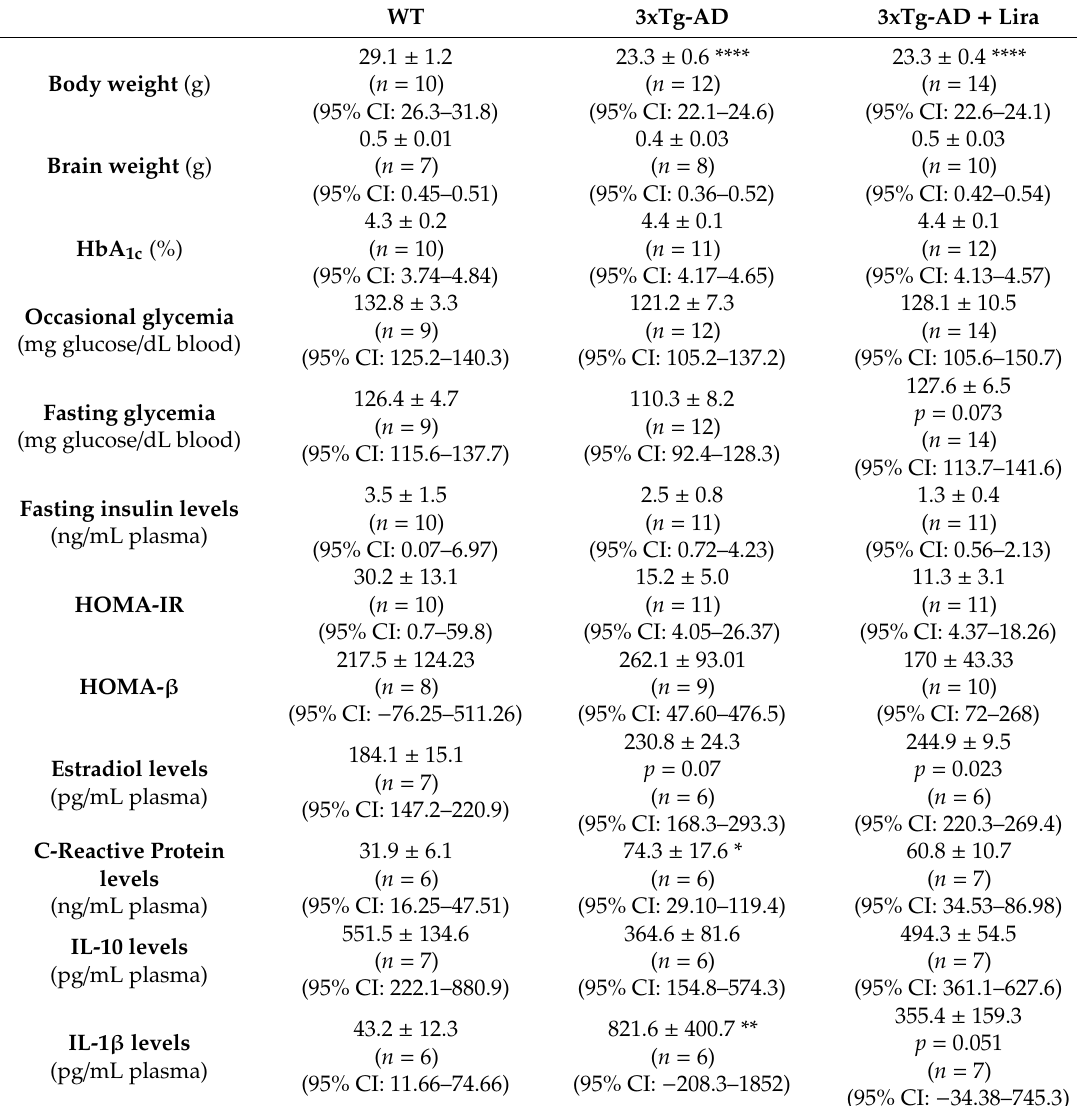
Table 1. E ff ect of liraglutide administration on peripheral features of female mice with early AD-like